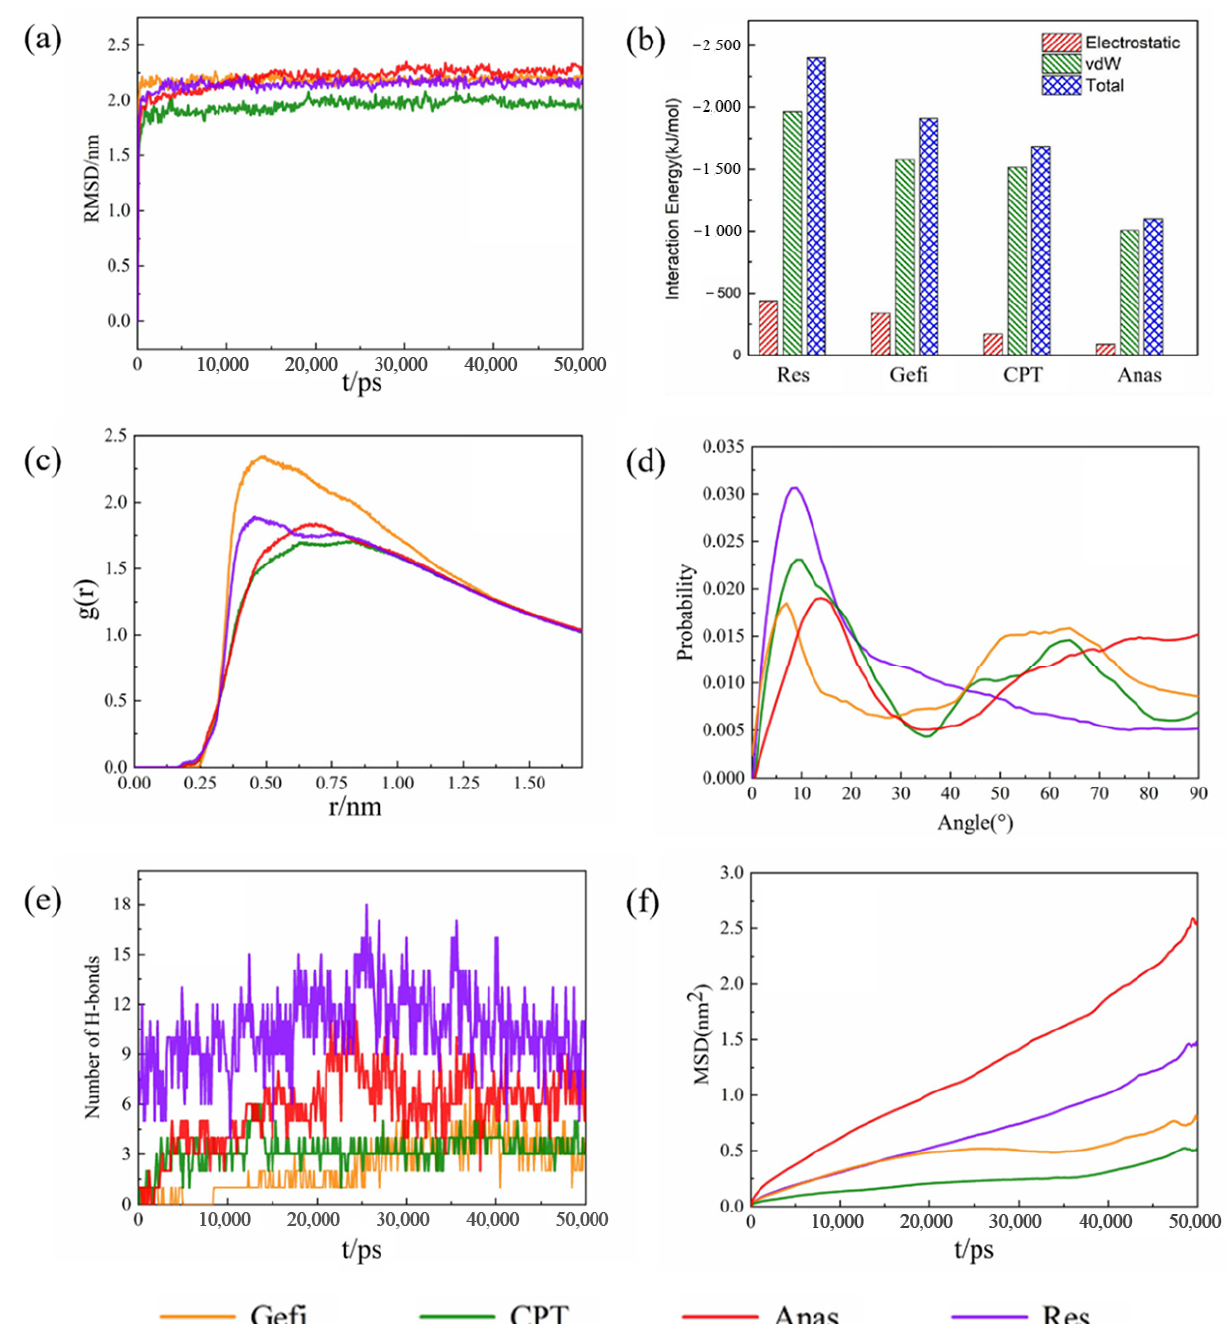
Figure 5. ( a ) The RMSD plots of the system with different drugs adsorbed on graphene as function of time ( b ) The average electrostatic, vdW, and total interaction energies of the systems with different drug molecules and GO. ( c ) Radial distribution functions (RDF) of the different drug molecules with GO. ( d ) The probability of the angle between the aromatic rings of the drug molecules and the GO plane. ( e ) Changes of the number of hydrogen bonds between the four kinds of drug molecules and GO over the time. ( f ) The MSD plots of the different drug molecules with GO.